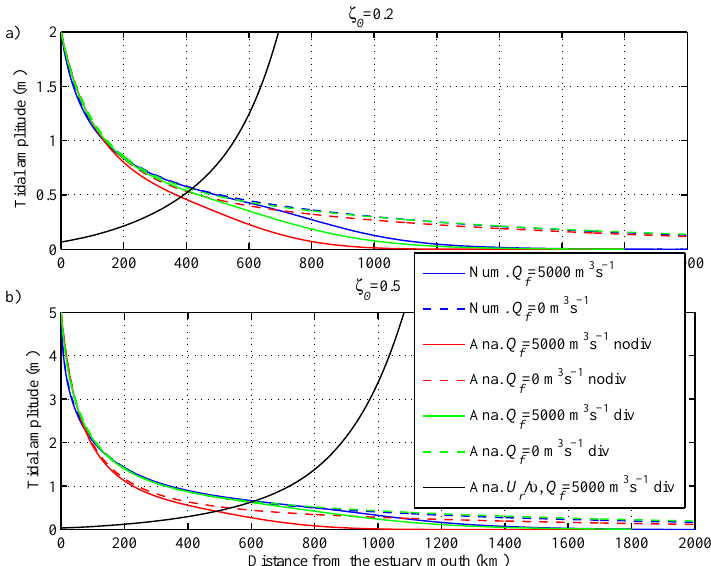
Fig. 8. Comparison between different analytical models and numerical results for given values of K =60m 1 / 3 s − 1 , b =352km, h =10m, B 0 =5000m, B min =300m, ζ 0 =0.2 (a) or ζ 0 =0.5 (b) . The drawn black line represents the river velocity to tide velocity amplitude ratio. The label “nodiv” indicates the models without considering the residual water level slope, while “div” denotes the models accounting for it using the approach described in Sect.